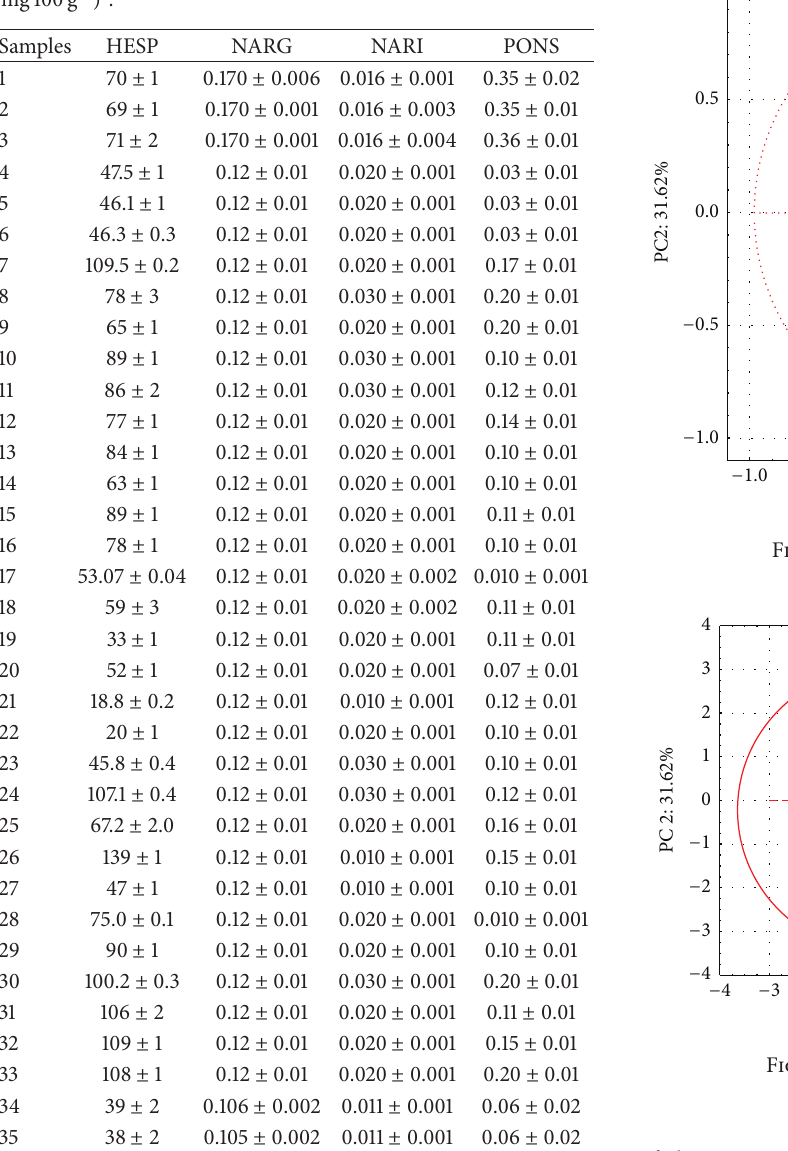
Table 1: Flavanone concentrations in orange juices samples (mg100 g − 1 ) a .